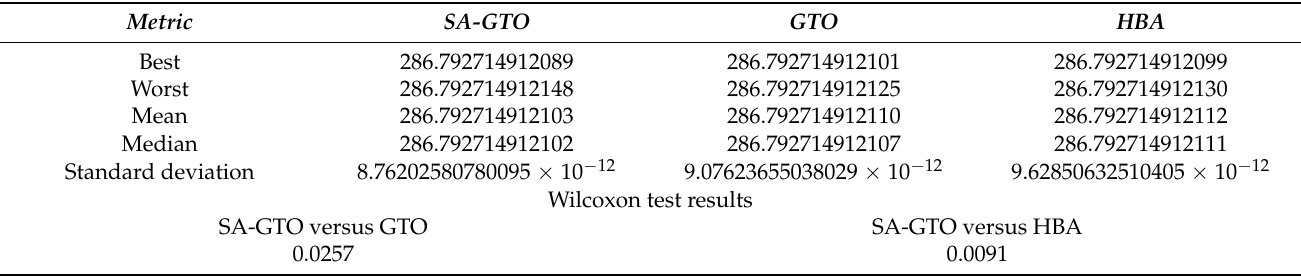
Table 8. Comparison of statistical measures of different algorithms.